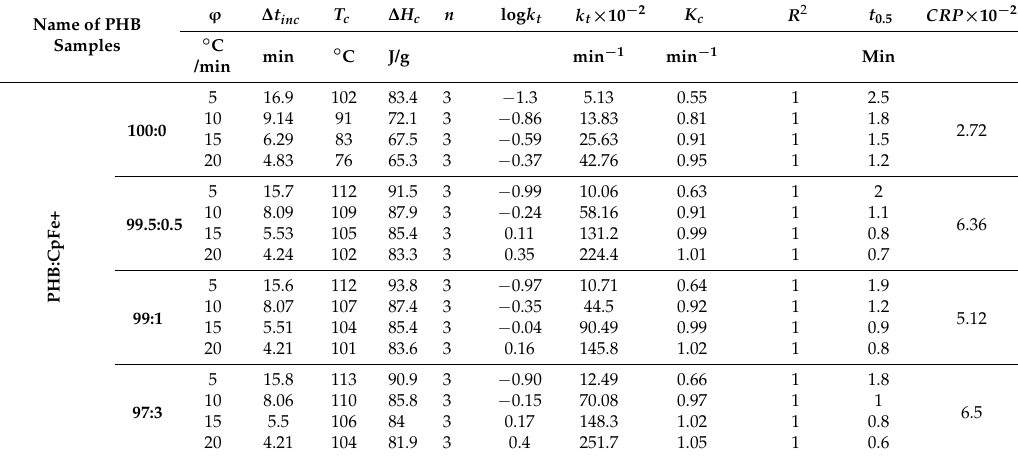
Table 3. Non-isothermal crystallization kinetics parameters of the pure PHB and PHB/CpFe + nanocomposites based on the modified Avrami model.